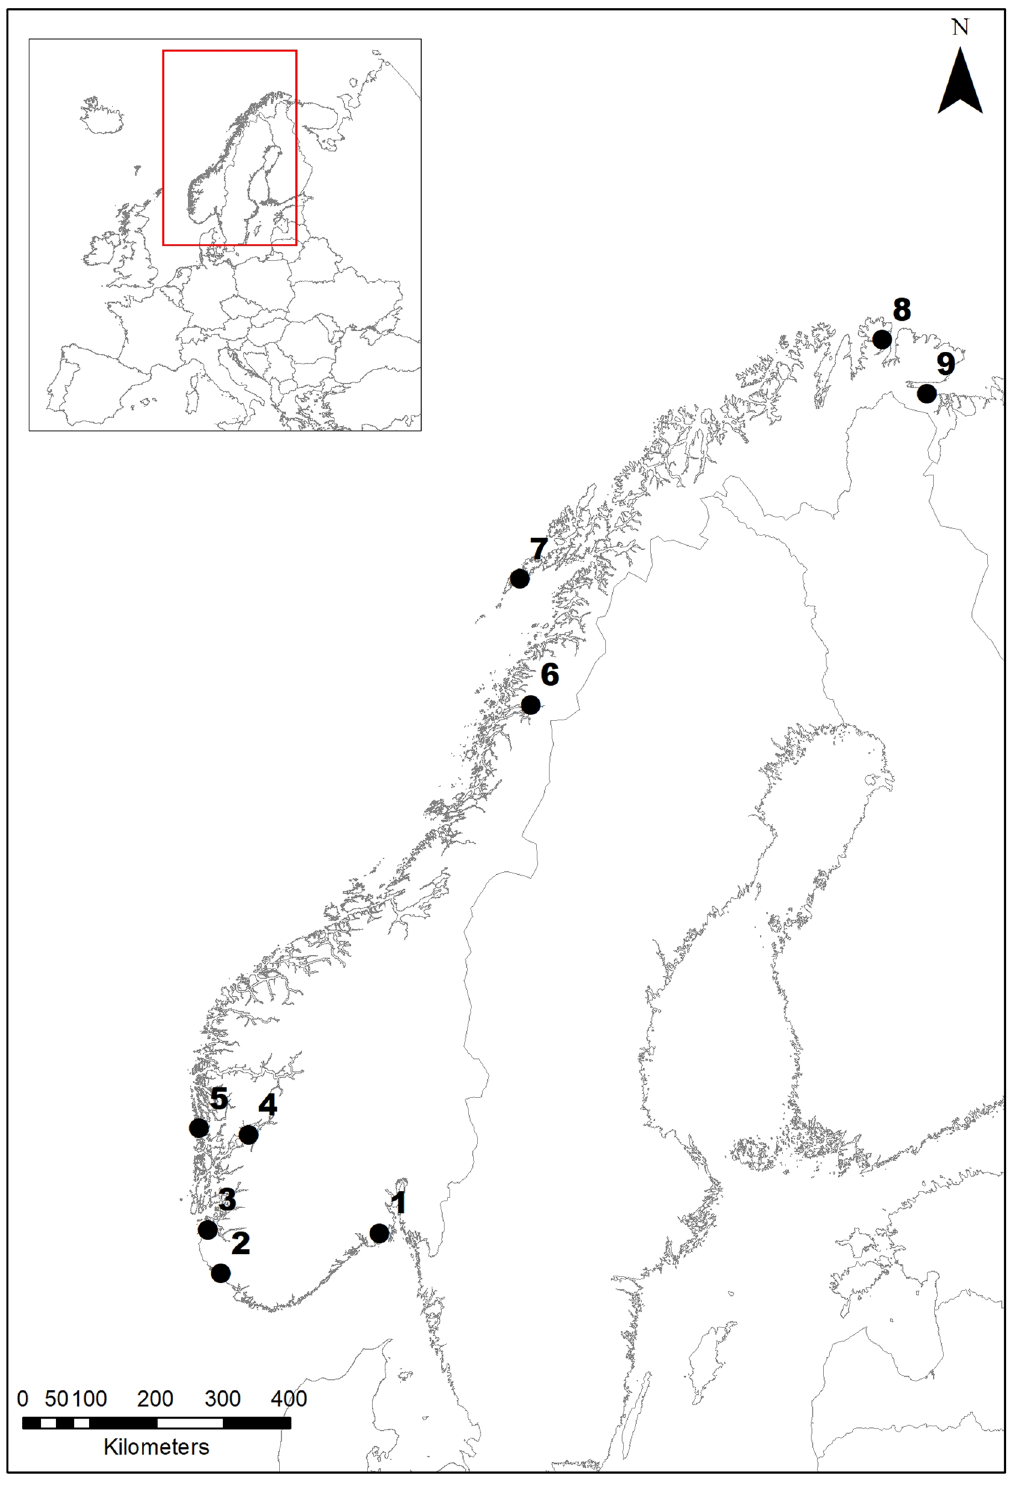
Figure 2: Fennoscandia with case study sites situated along the coast of Norway. 1. Auve, 2. Slettabø, 3. Vistehola, 4. Sævarhelleren, 5. Kotedalen, 6. Stiurhelleren, 7. Storbåthallaren, 8. Iversfjord, and 9. Rissebávti/Gressbakken Nedre Vest. Map by G. Skogvold, UiT – The Arctic University of